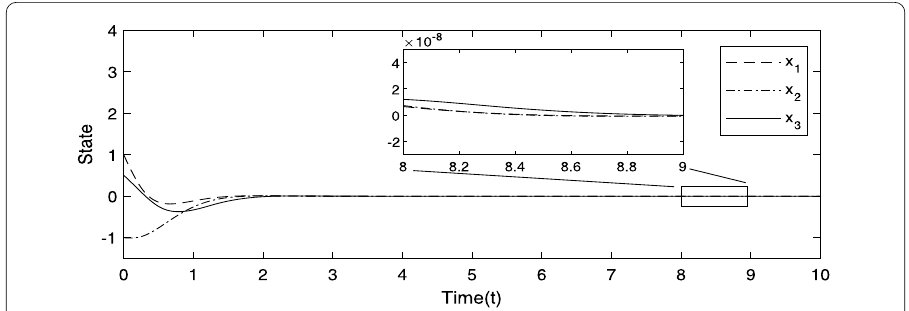
Figure 1 State response trajectories for the open-loop systems without